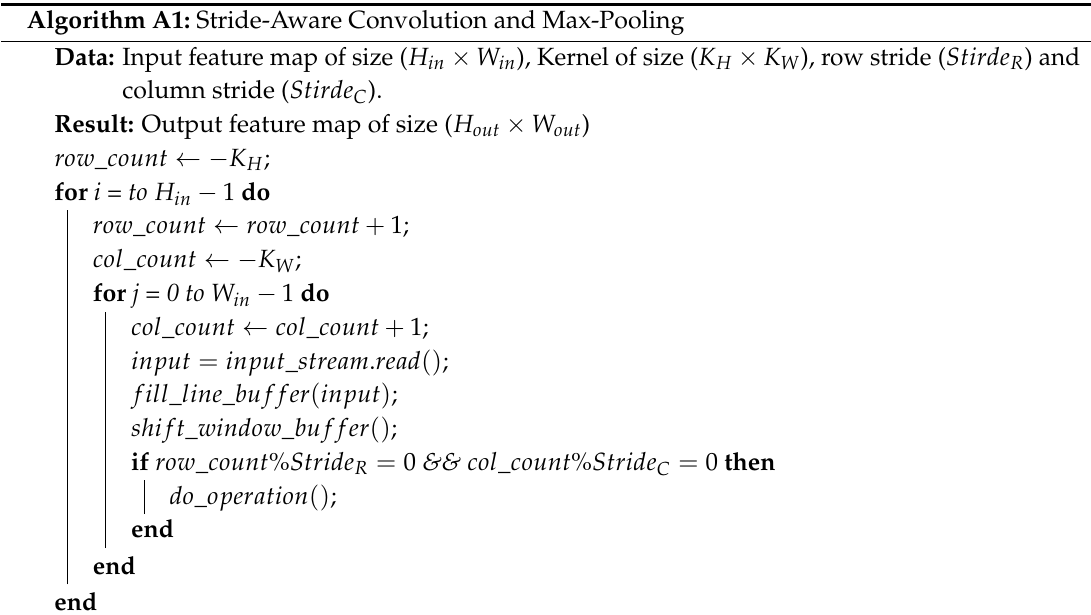
Algorithm A1: Stride-Aware Convolution and Max-Pooling